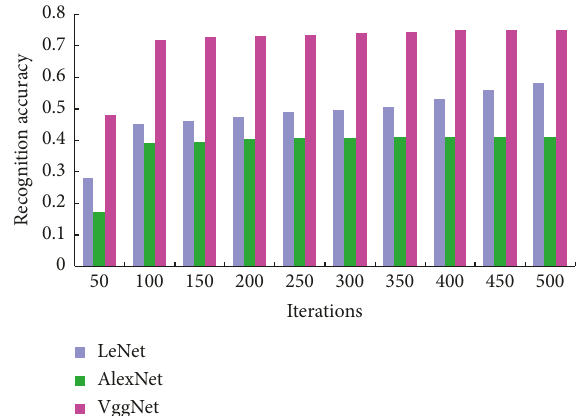
Figure 12: The relationship between the classification accuracy of the model and the number of